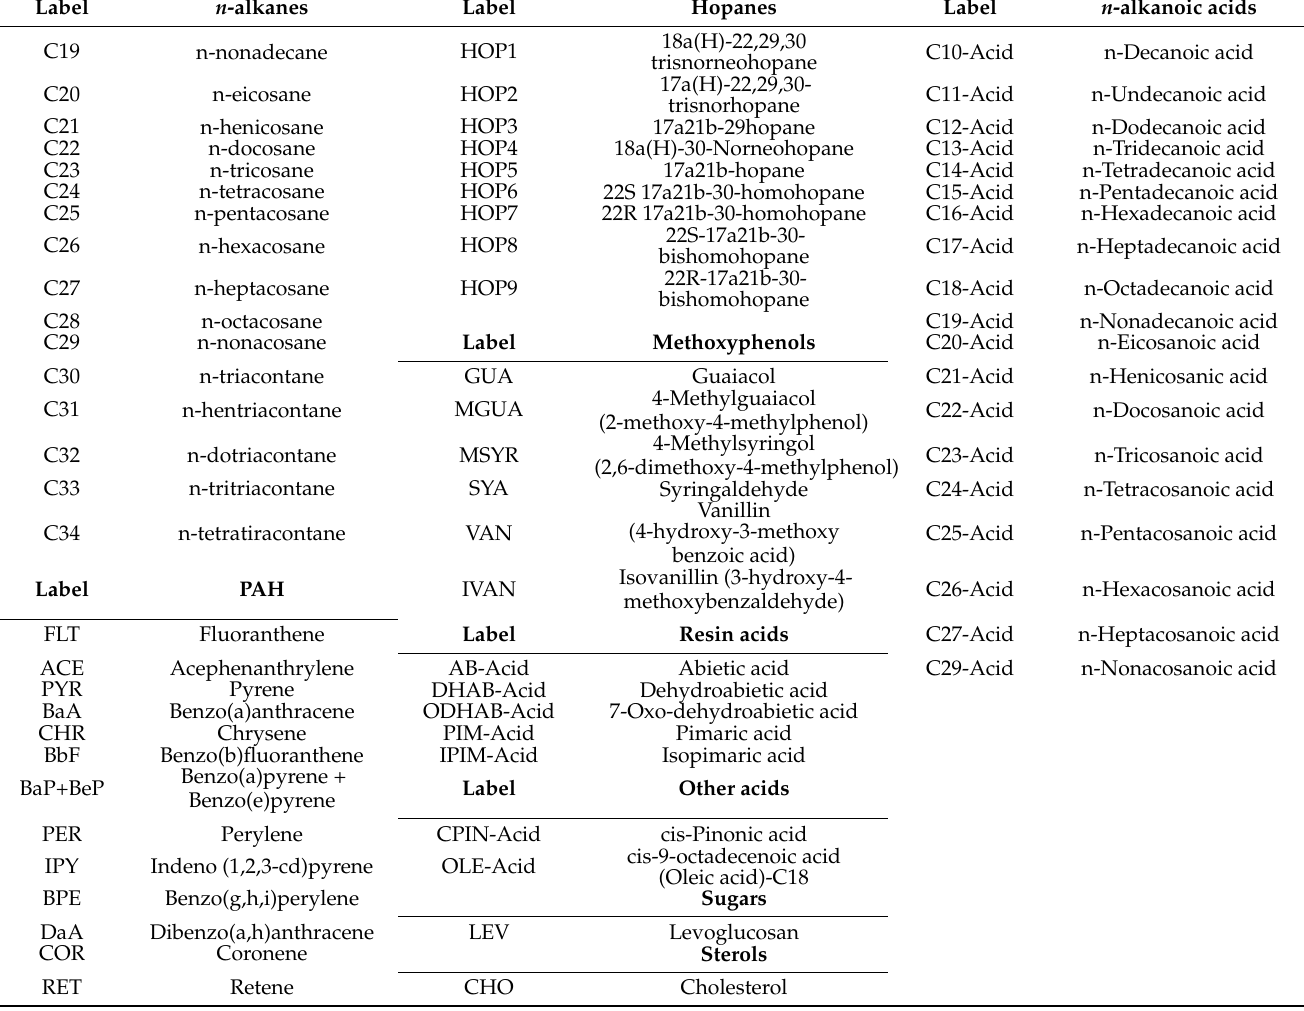
Table 2. List of the extractable organic compounds for this